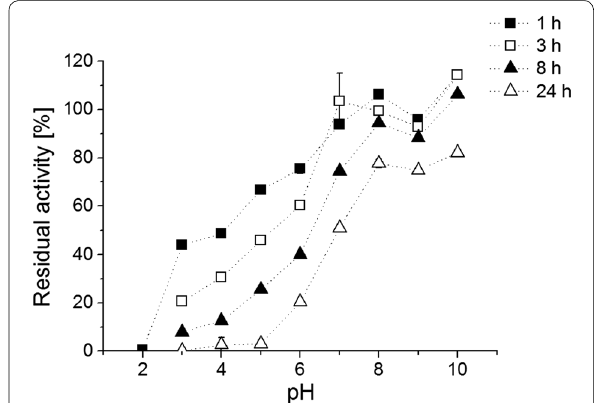
Fig. 3 Stability of Mrl2 at different pH values. After 1 h ( black square ), 3 h ( white square ), 8 h ( black triangle ) and 24 h ( white triangle ) incubation the residual activity (indicated in % of initial activity) was determined